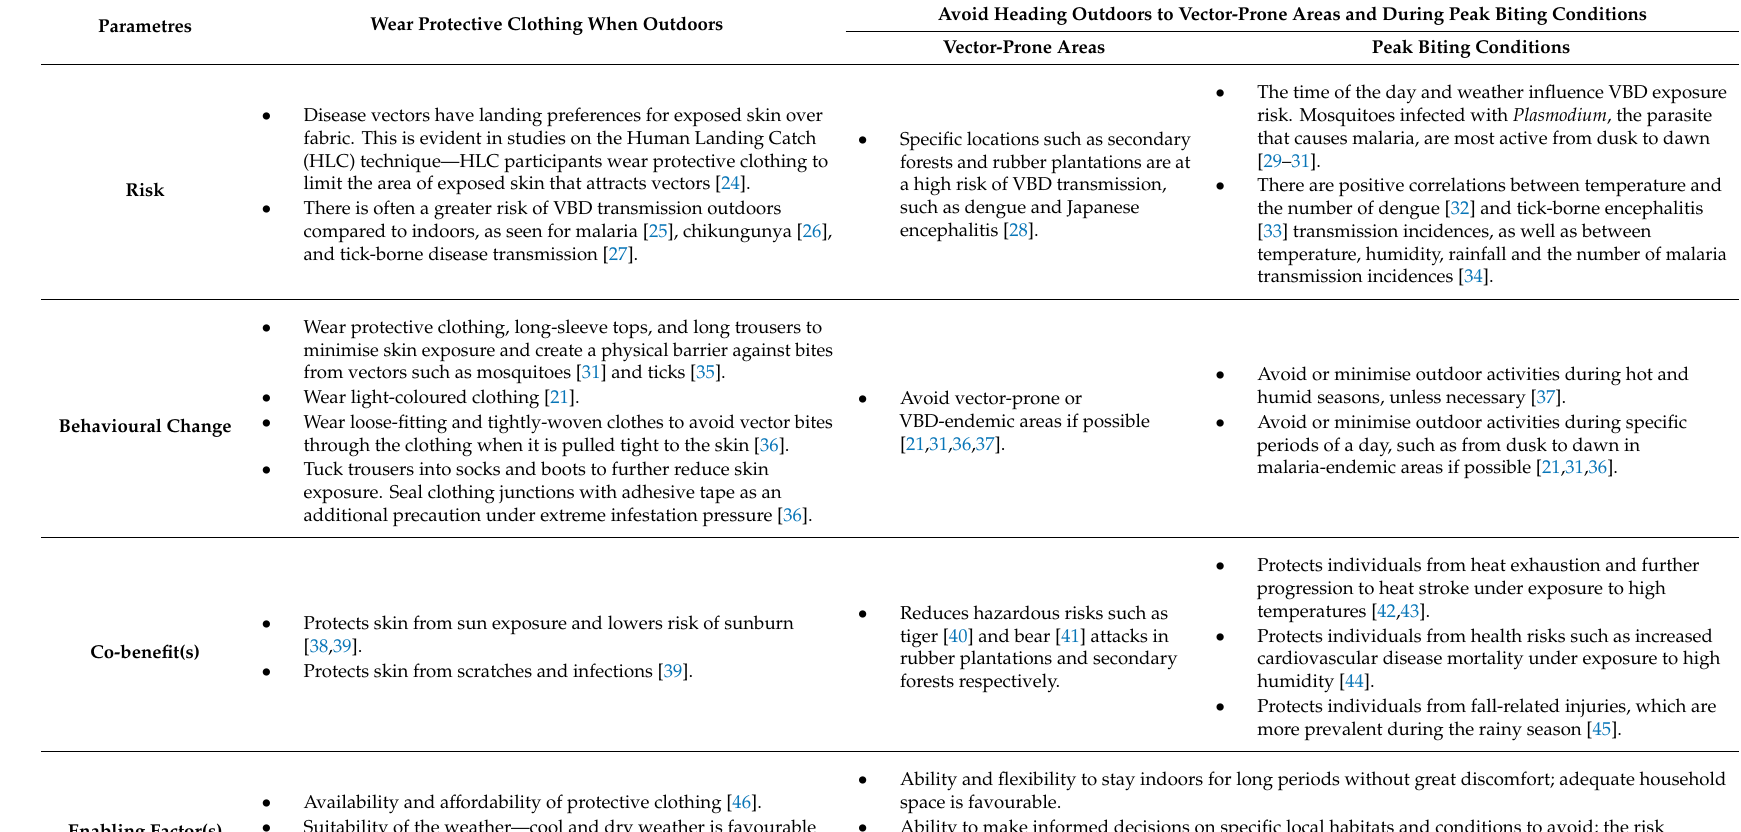
Table 1. Personal Protection Practices as Health Emergency and Disaster Risk Management (Health-EDRM) Primary Prevention Approaches against Vector-borne Diseases (VBDs) (Part